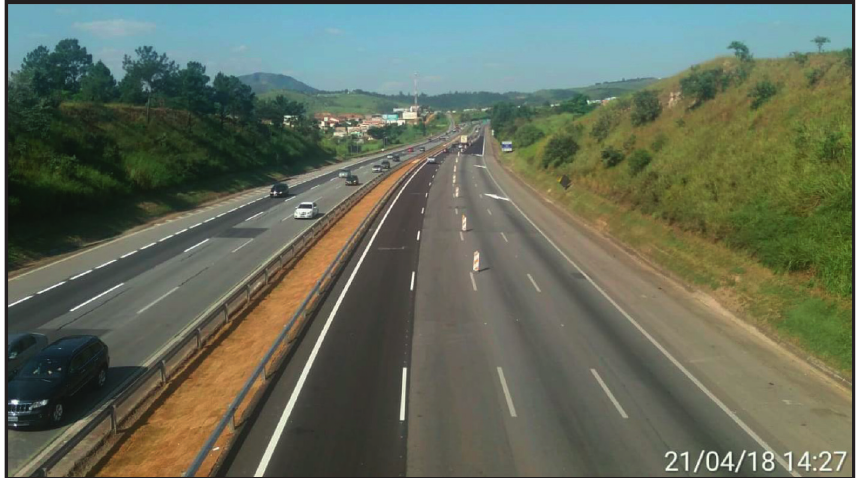
Figure 8: Additional lane to the left opened to traffic.